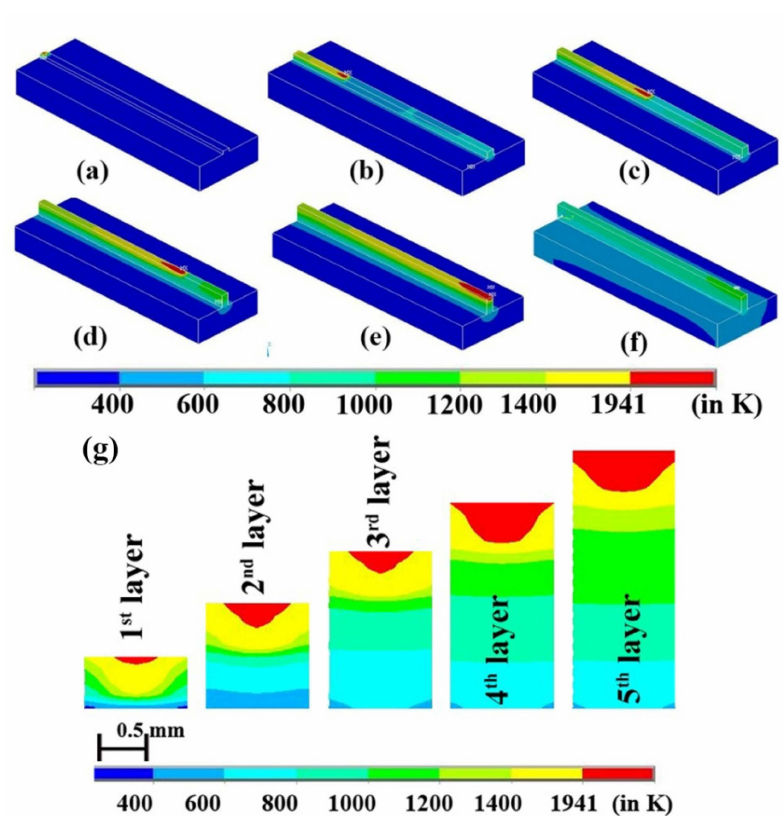
Figure 5. Laser movement and cooling over different layers ( a – f ) and changing melt-pool dimensions of laser scanning during a laser AM process of 5 layers for pure Ti for dataset#6 ( g